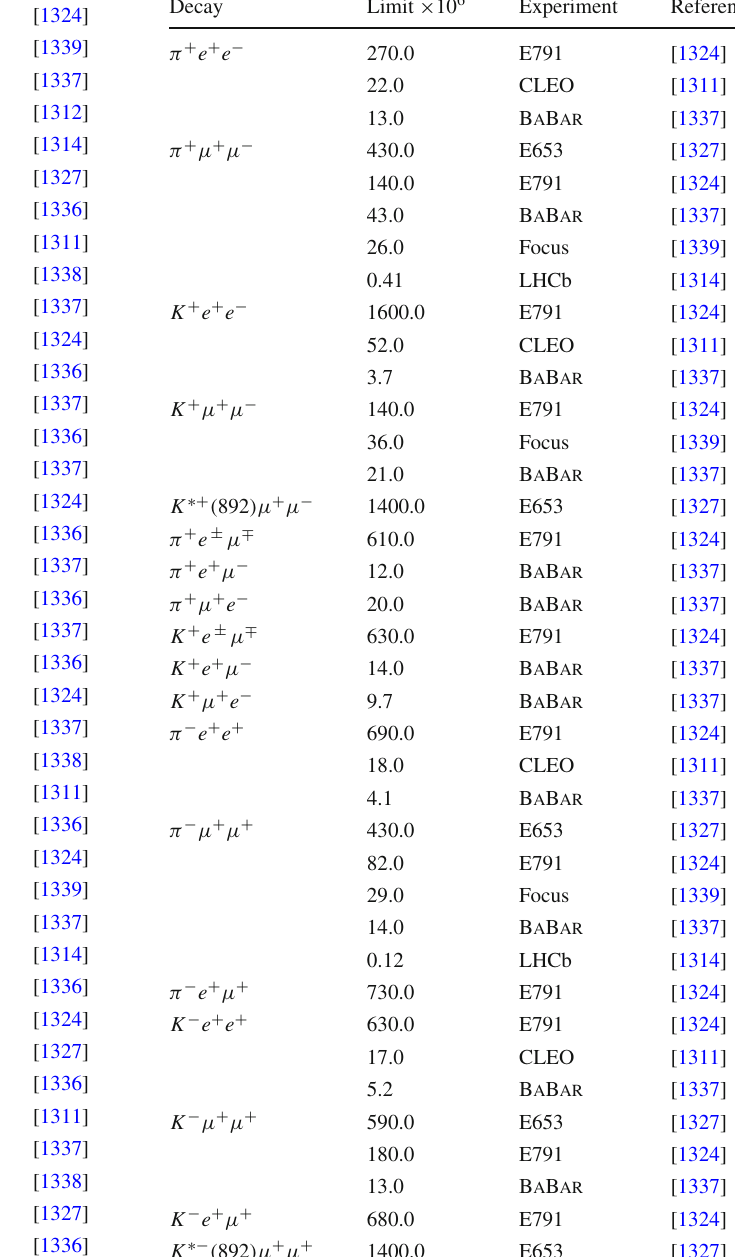
Table 302 Upper limits at 90% C.L. for D + s